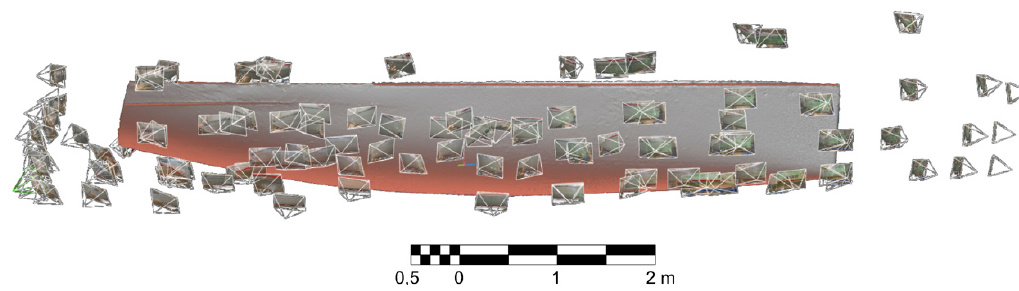
Figure 14. Imaging stations in the second stage.